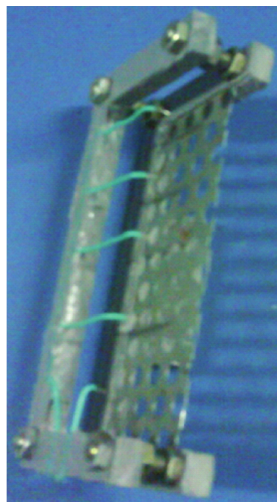
Figure 2: Pine-to-plate electrode